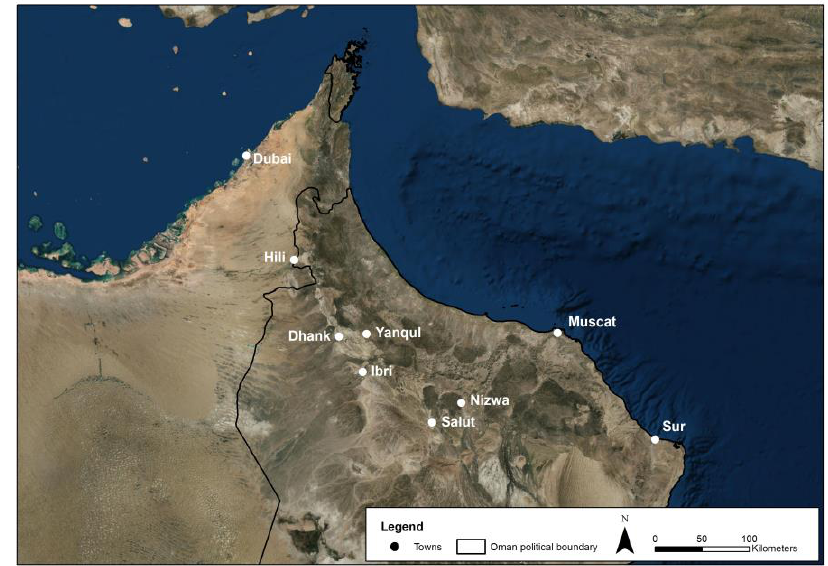
Figure 1. Regional map showing the contemporary town of Dhank. The exact location of ’Uqdat al-Bakrah is not indicated given its sensitivity and need for cultural heritage protection.